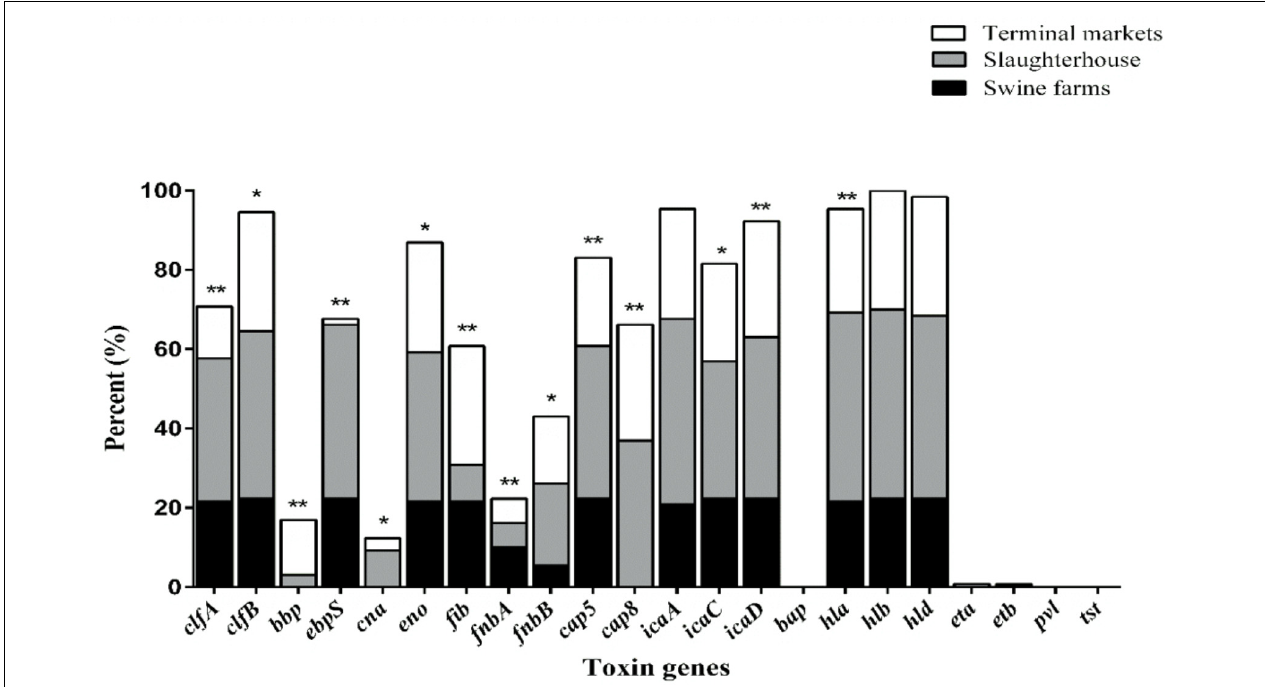
FIGURE 1 | The distribution of 22 toxin genes in S. aureus isolates from different stages of pork production. The percentage of strains that were positive for each toxin gene was calculated based on the origin of each sample isolate. Pearson’s chi-square test (two-tailed) was used to test the difference in the virulence determinants distribution among isolates from different sources and run based on multiple group comparison of different sources. ∗ Demonstrates that the distribution of toxin genes was statistically significantly different in isolates from different sources ( p < 0.05); ∗∗ demonstrates that the distribution of toxin genes was more significantly different in isolates from different food sources ( p < 0.01). TABLE 3 | The toxin genes number of S. aureus isolates from different stages of pork production. Number of the toxin Number of S. aureus isolates a Total number of gene per isolate ( n ) isolates (130) b